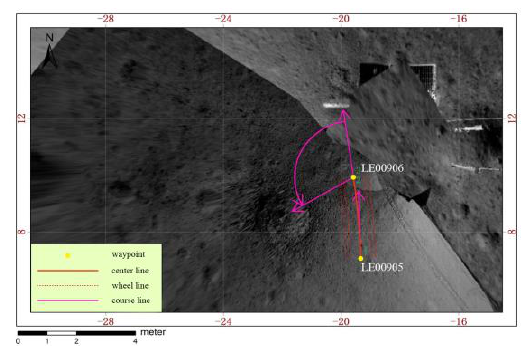
Figure 9. DOM at waypoint LE00905 and searched path in overhead view.